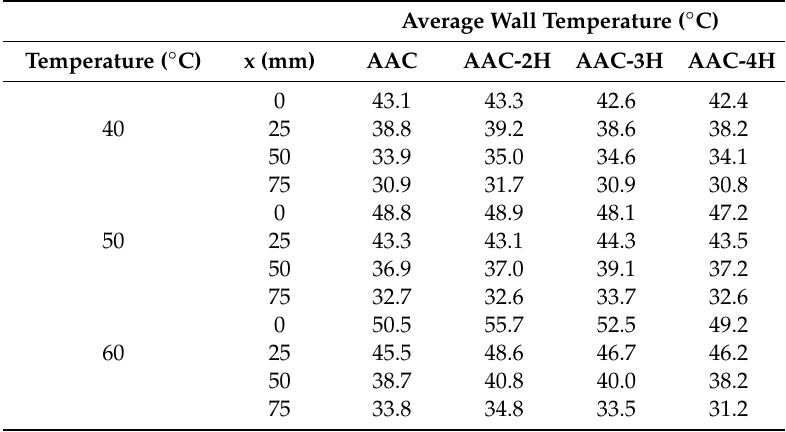
Figure 5. Temperature evolution of AAC wall with the two PCM-filled conical holes at 40 ° C. Table 1. Average wall temperature of AAC.